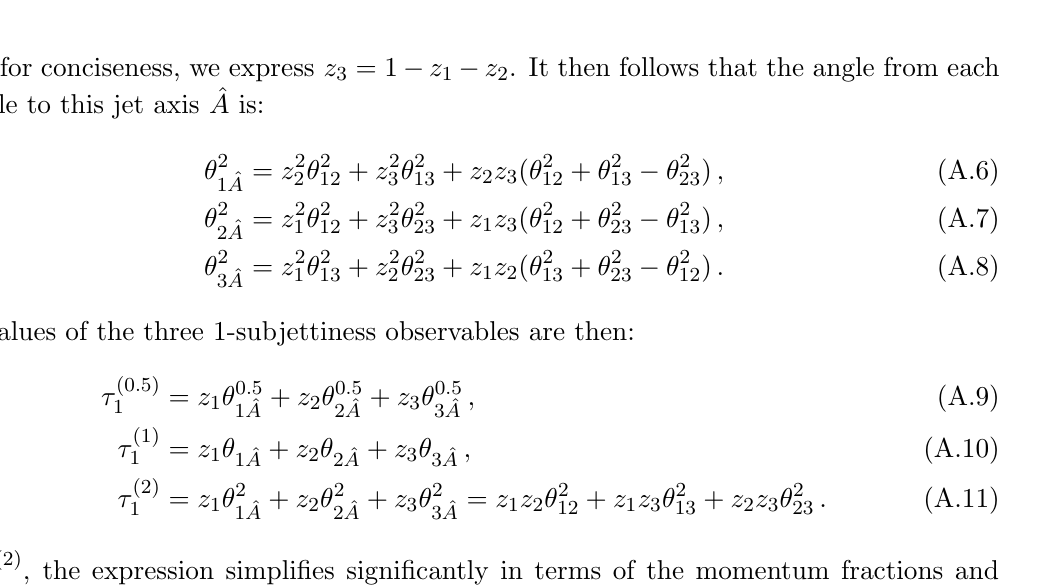
Figure 7. Con(cid:12)guration in a plane of a jet with three particles. Pairwise angles (cid:18) ij and momentum fractions z i of the individual particles are labeled. Momentum conservation enforces that z 3 = 1 z 1 z 2 (cid:0) (cid:0)